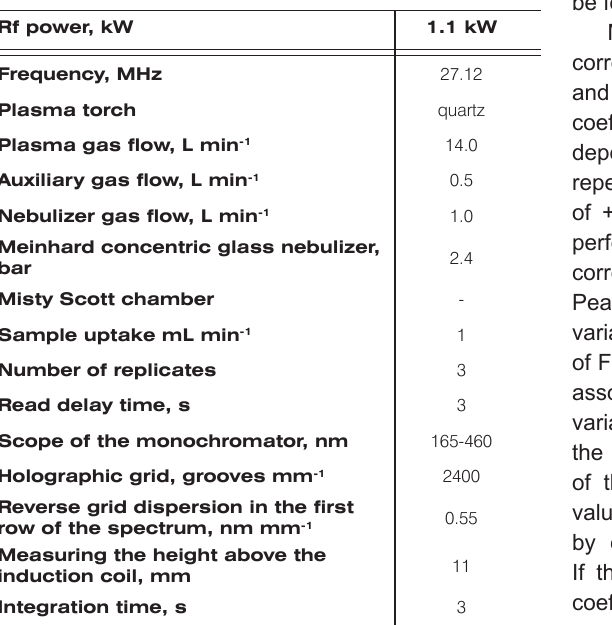
Table 1. Measurement conditions for ICP-OES (SPECTROFLAME ICP M, Spectro Analytical Instruments, Germany).